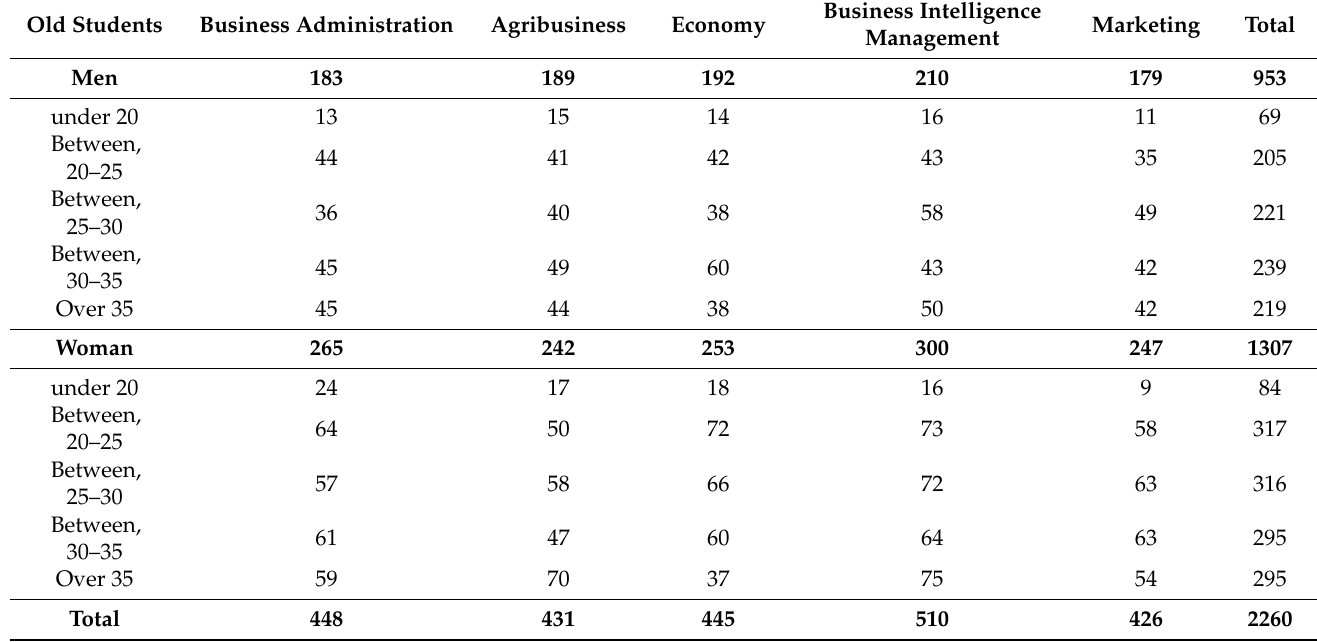
Table 12. Table with general data of the surveyed population, with segmentation by age, gender, and career to which they belong.